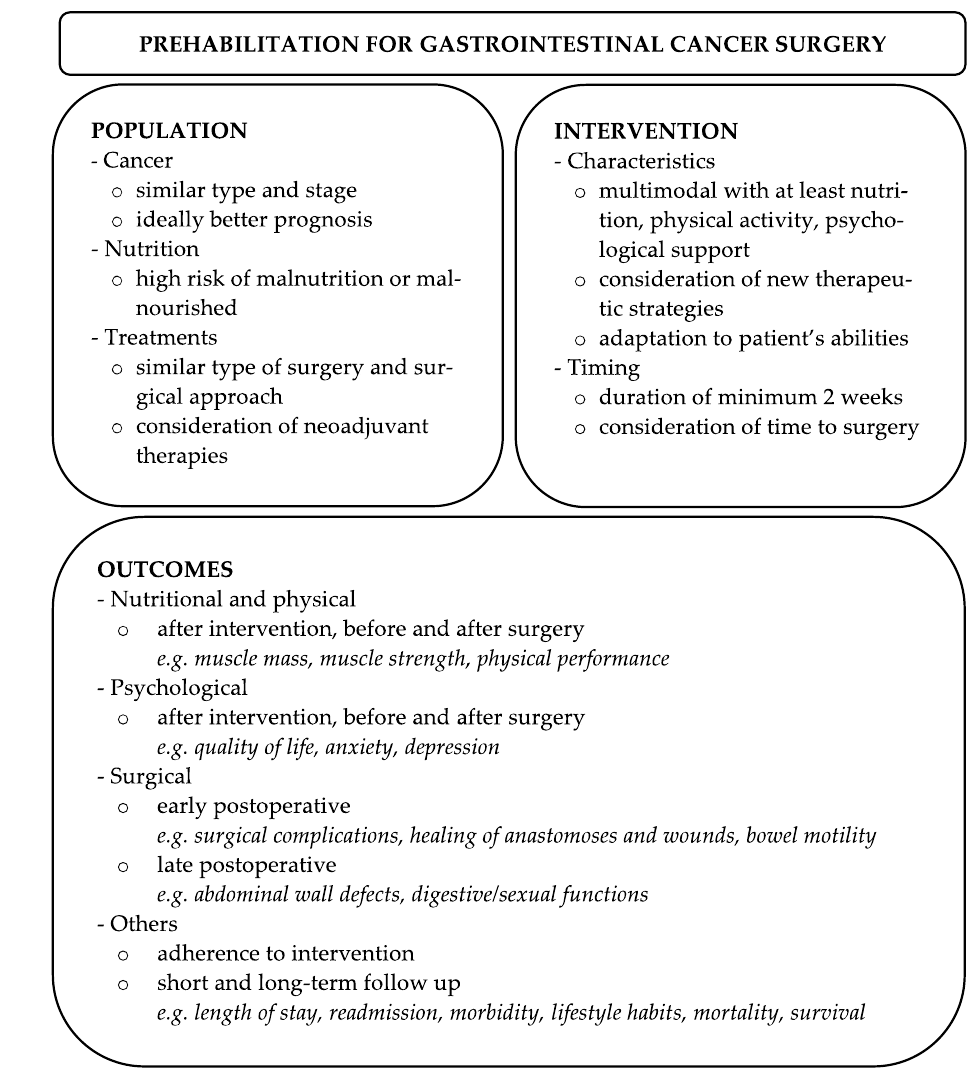
Figure 2. Recommendations for future studies evaluating prehabilitation in GI cancer surgery.